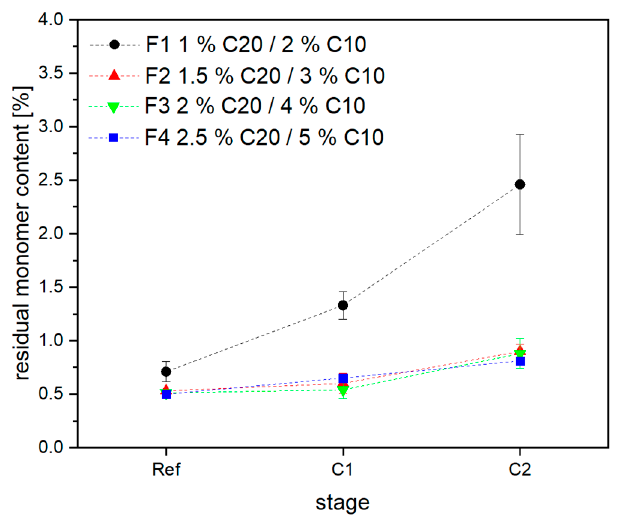
Figure 13. Residual monomer content of the four formulations in different stages.